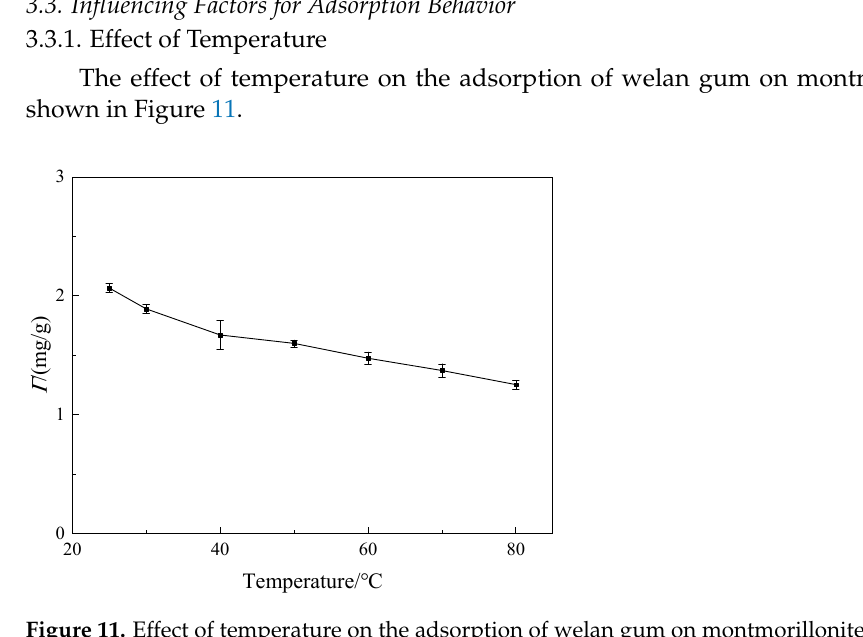
Figure 11. Effect of temperature on the adsorption of welan gum on montmorillonite.